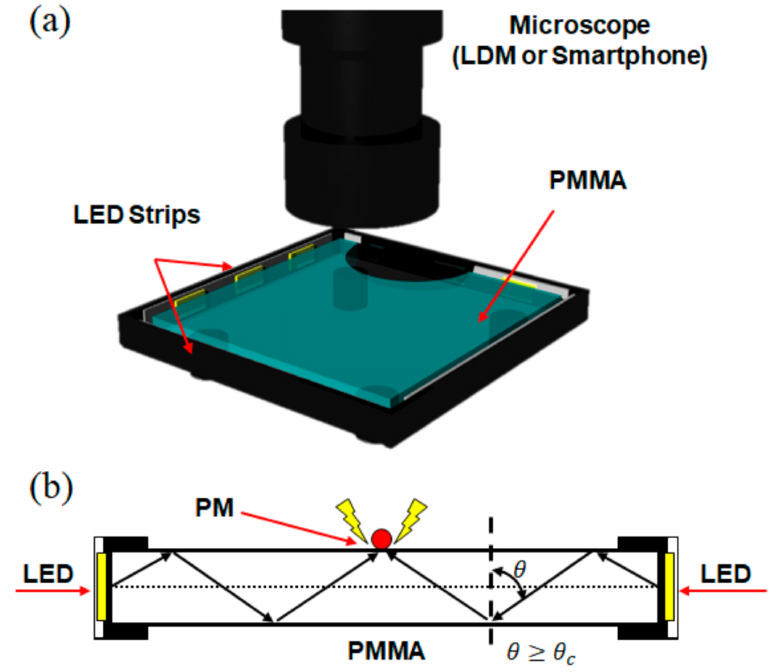
Figure 1. Schematics of the developed side illumination total internal reflection (TIR)-based particu- late matter (PM) detection system. ( a ) Microscope (long-distance microscope (LDM) or smartphone- compatible toy microscope) can directly image the PM on the PMMA (Poly methyl